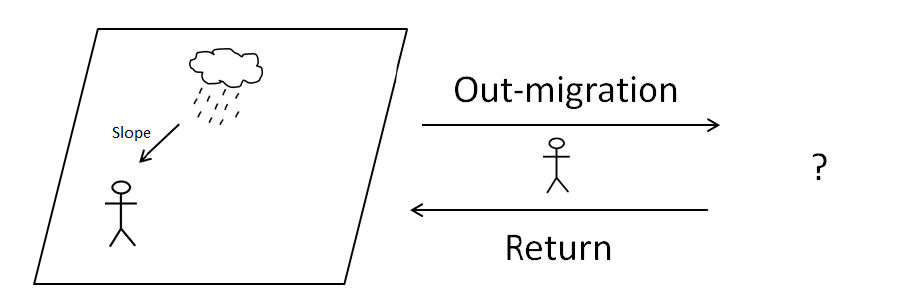
Fig. A1.7 Diagram drafted for the ABM described by Mena et al. (2011)